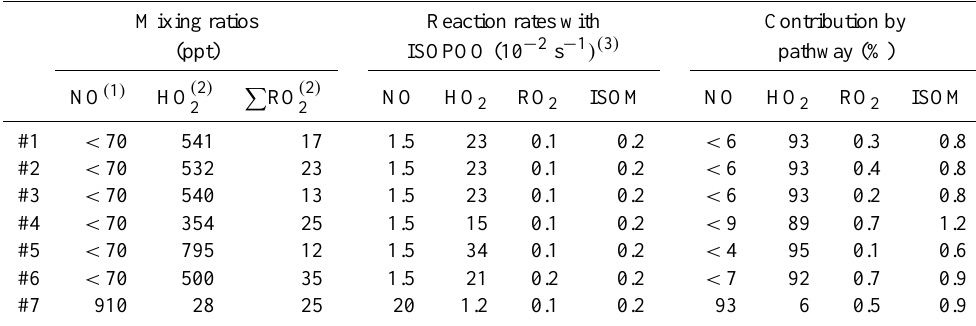
Table 3. Modeled relative importance of competing reaction pathways for Experiments #1 to #7. Mixing ratios Reaction rates with Contribution by (ppt) ISOPOO (10 − 2 s − 1 ) ( 3 ) pathway